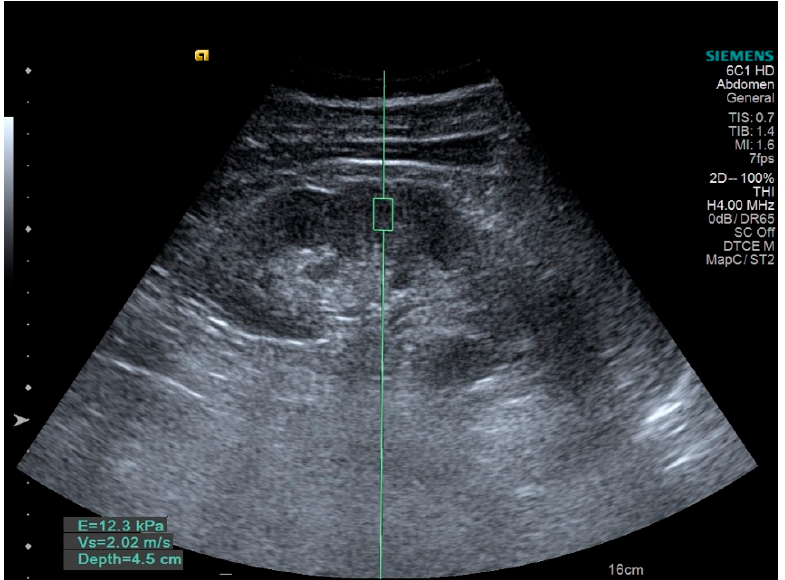
Figure 2. ARFI; SWV = 2.02 m/s.